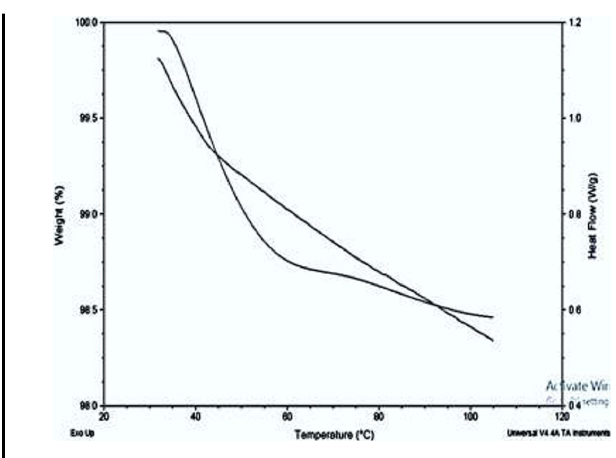
FIG. 9. DSC AND TGA CURVE FOR SAMPLES AGED FOR 5 DAYS